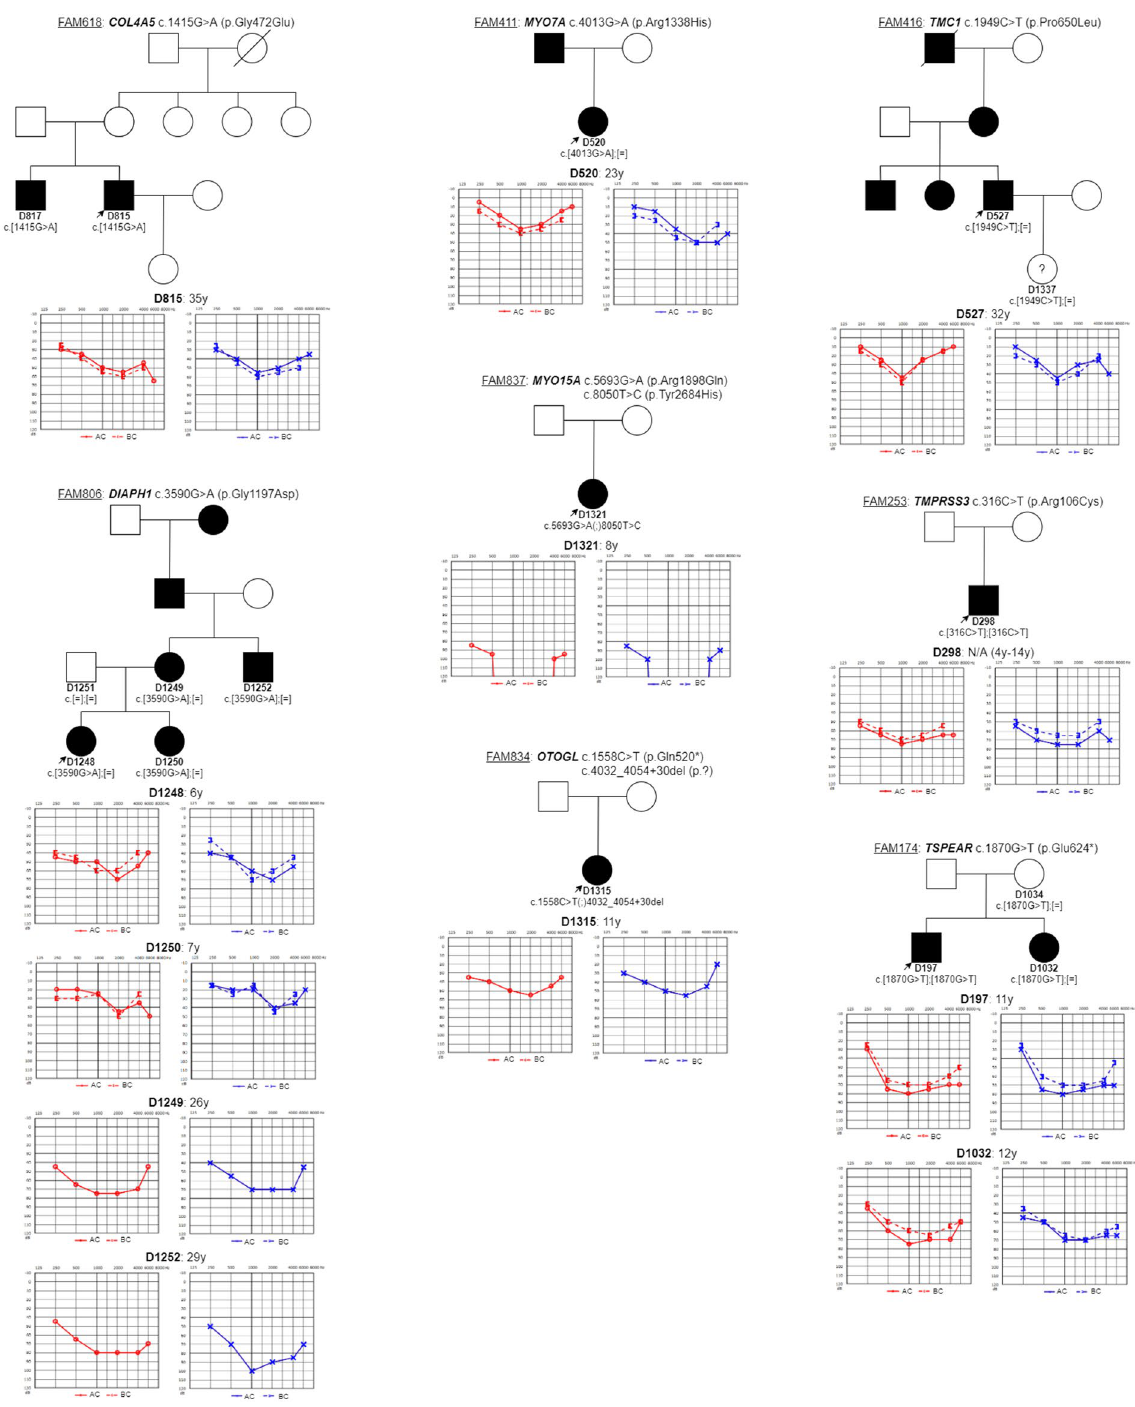
Figure 2. Pedigrees and audiograms of the patients with dominant variants in genes DIAPH1 , MYO7A , TMC1 , recessive variants in genes MYO15A , OTOGL , TMPRSS3 , TSPEAR and variant with X-linked inheritance ( COL4A5 ). The age at examination by pure tone audiometry is